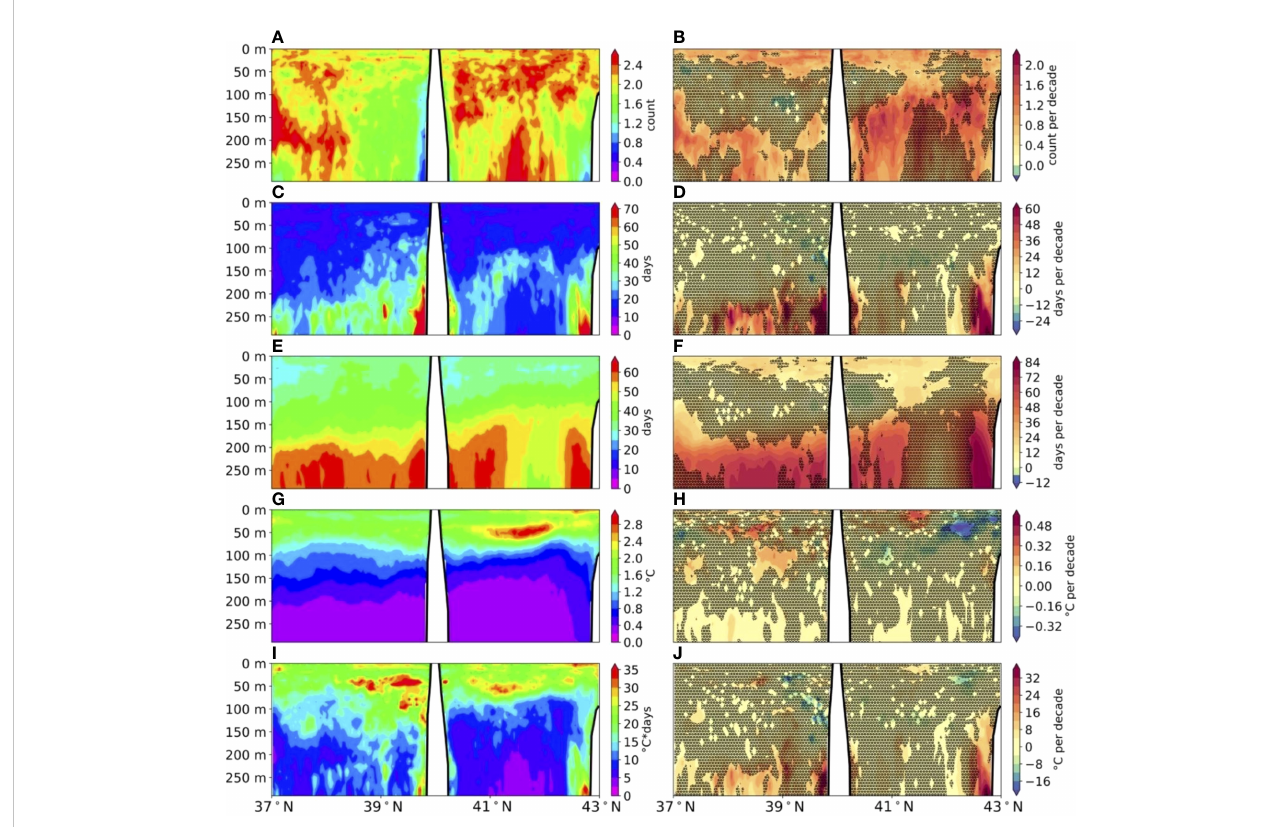
FIGURE 5 Vertical sections of means (left panels, A, C, E, G, I ) and linear trends (right panels, B, D, F, H, J ) over the period 1987-2019 of annual MHW frequency ( A, B, in count), duration ( C, D, in days), total days ( E, F, in days), maximum intensity ( G, H, in °C) and cumulative intensity ( I, J , in °C*days), as detected from MEDREA temperature in the upper 300 m, along the western longitudinal section (as displayed in Figure 1). The black line indicates the bathymetry. Black hatches indicate where trend values are not signi fi cant at the 95% con fi dence level based on a Mann-Kendall trend